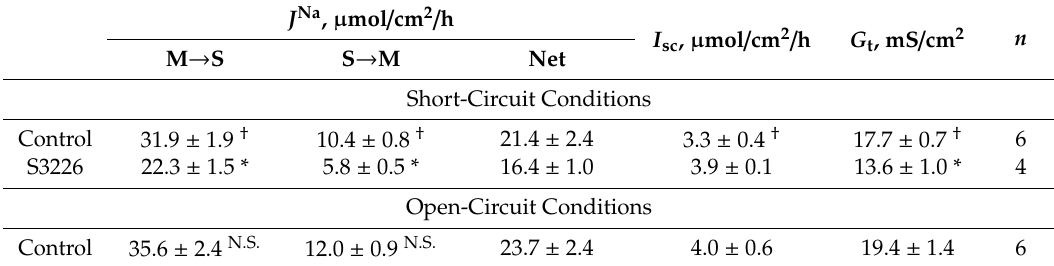
Table 2. Basal 22 Na + flux and electrical parameters in cldn15 − / −